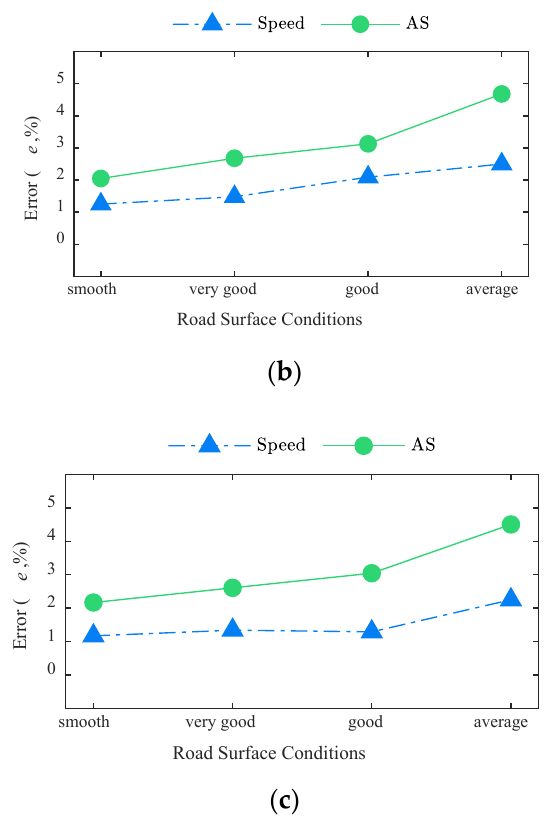
Figure 10. Identification performance of axle spacings and speed under different RSCs: ( a ) 2-axle trucks; ( b ) 3-axle trucks; ( c ) 5-axle trucks. AS, axle spacing .